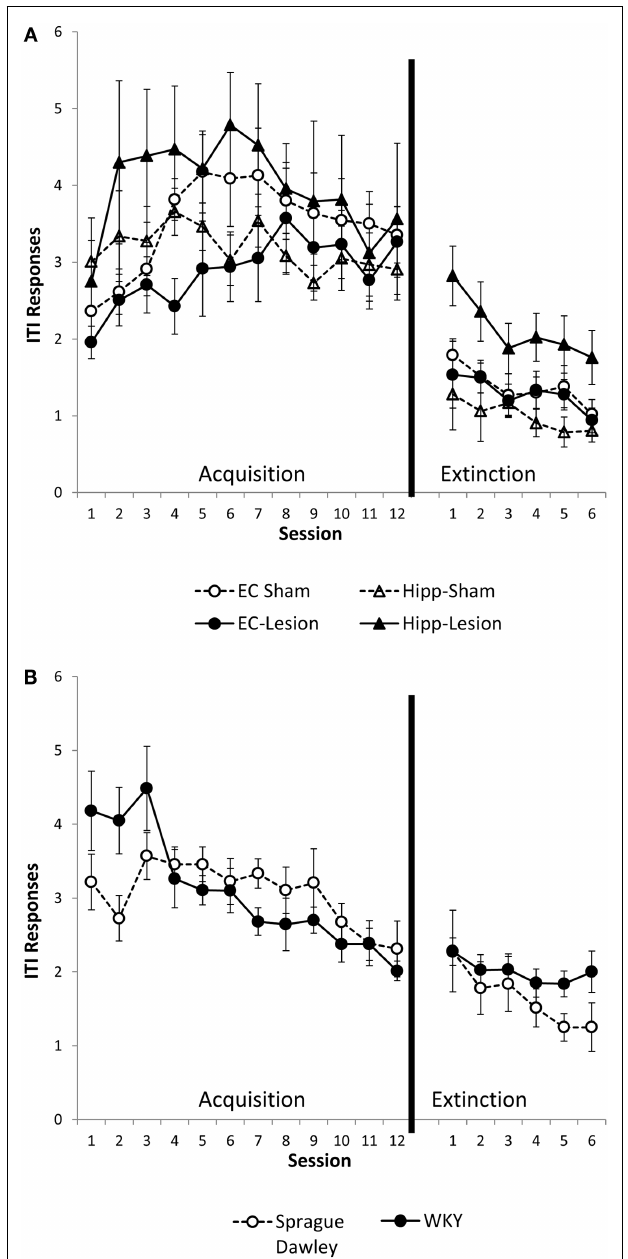
FIGURE 3 | ITI responding during the first minute of the intertrial interval (ITI) . Hippocampal lesion increased ITI responding during the first minute of the ITI during acquisition and extinction (A) . Group differences were not present during the second or third minute of the ITI (not shown). WKY rats showed a trend for increased ITI responding during the first minute of the ITI in the avoidance phase, but not extinction (B) . Strain differences were not observed during the second or third minute of the ITI (not